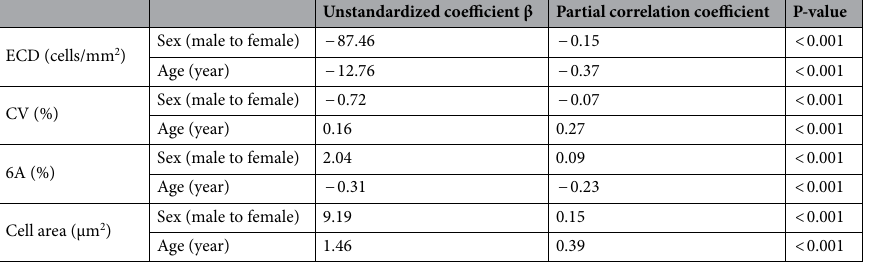
Table 3. Multiple linear regression analysis of endothelial cell density and morphology of healthy Japanese eyes. ECD, corneal endothelial cell density; CV, coefficient of variation in cell area; 6A, appearance rate of hexagonal cells.